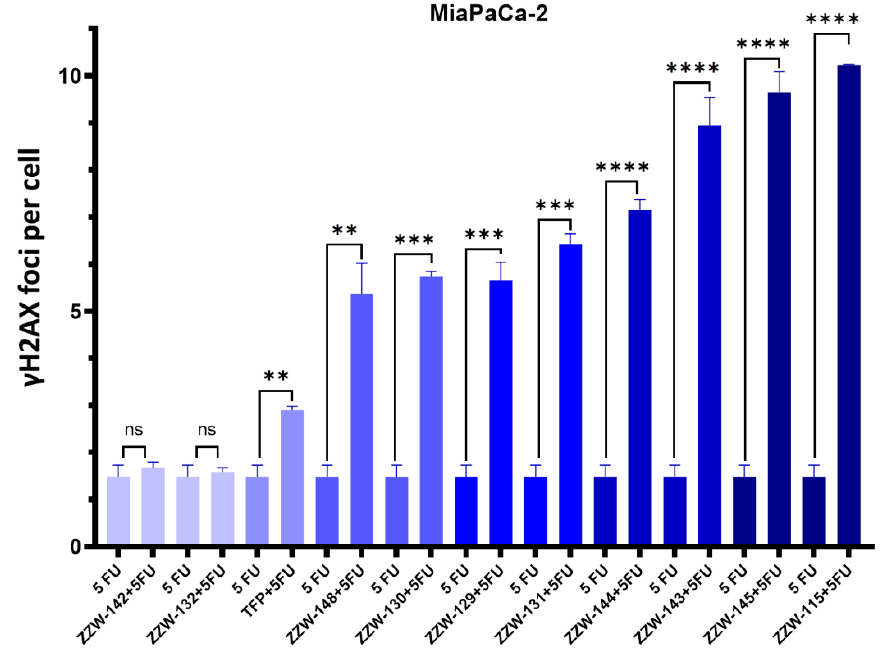
Figure 5. NUPR1 inhibition by ZZW-115-derived compounds potentiated the efficacy of 5-FU in MiaPaCa-2 cells. The efficacy of 5-FU to generate DNA breaks in primary PDAC cells and the boosting effect of ZZW-115 was evaluated by γ H2AX immunofluorescence staining. Quantifications of 3 independent experiments were used to evaluate the statistical significance, and they are shown as graphics. ** p < 0.01; *** p < 0.001; **** p < 0.0001 (1-way ANOVA, Tukey’s post hoc test). Data represent mean ± SEM, n = 3.